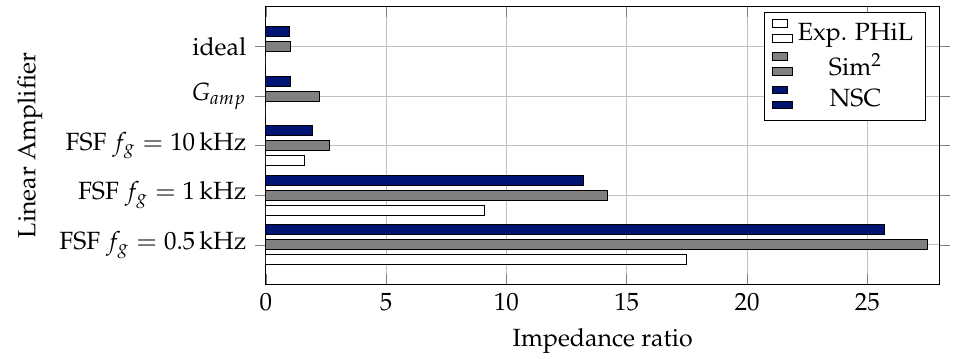
Figure 21. Impedance ratio as stability limit for analysis with a linear